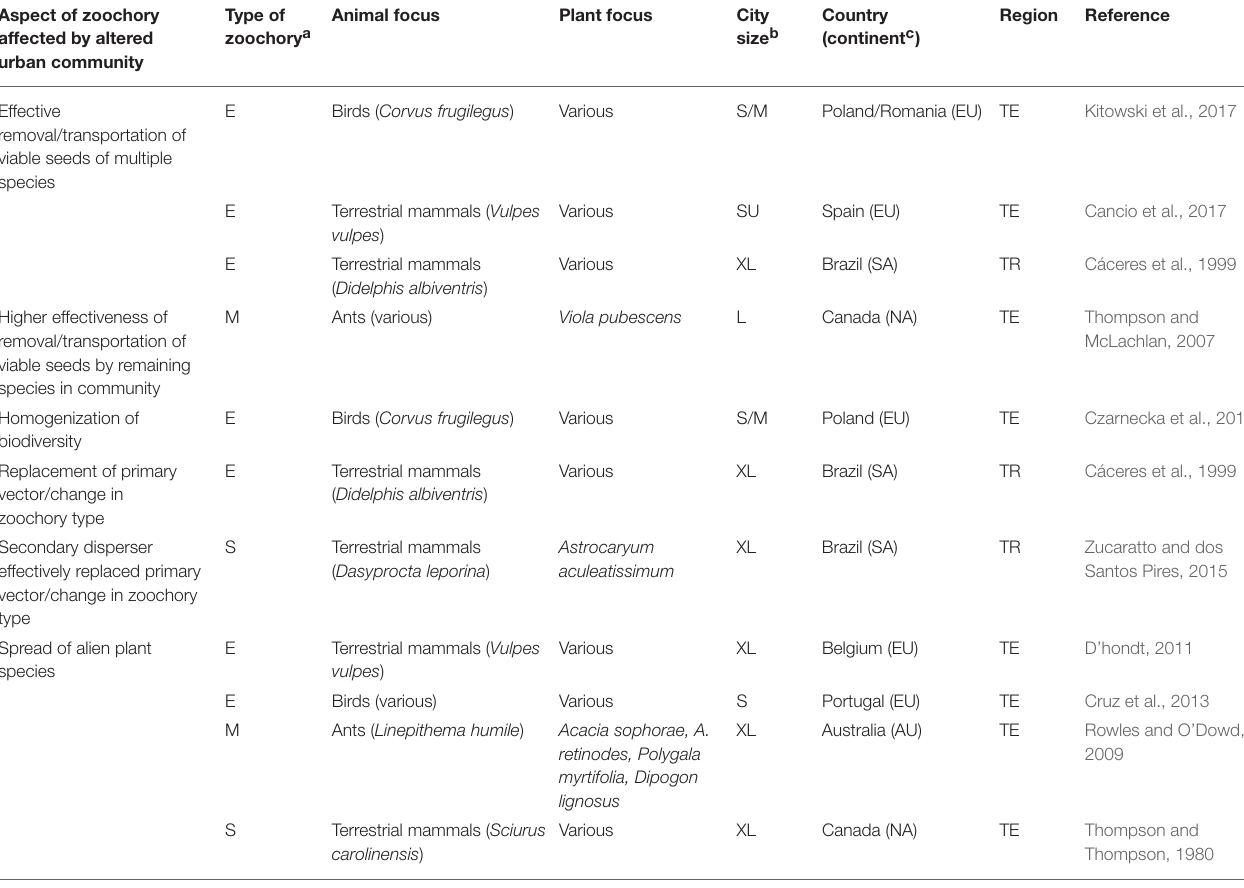
TABLE 2 | Effects of altered communities on urban